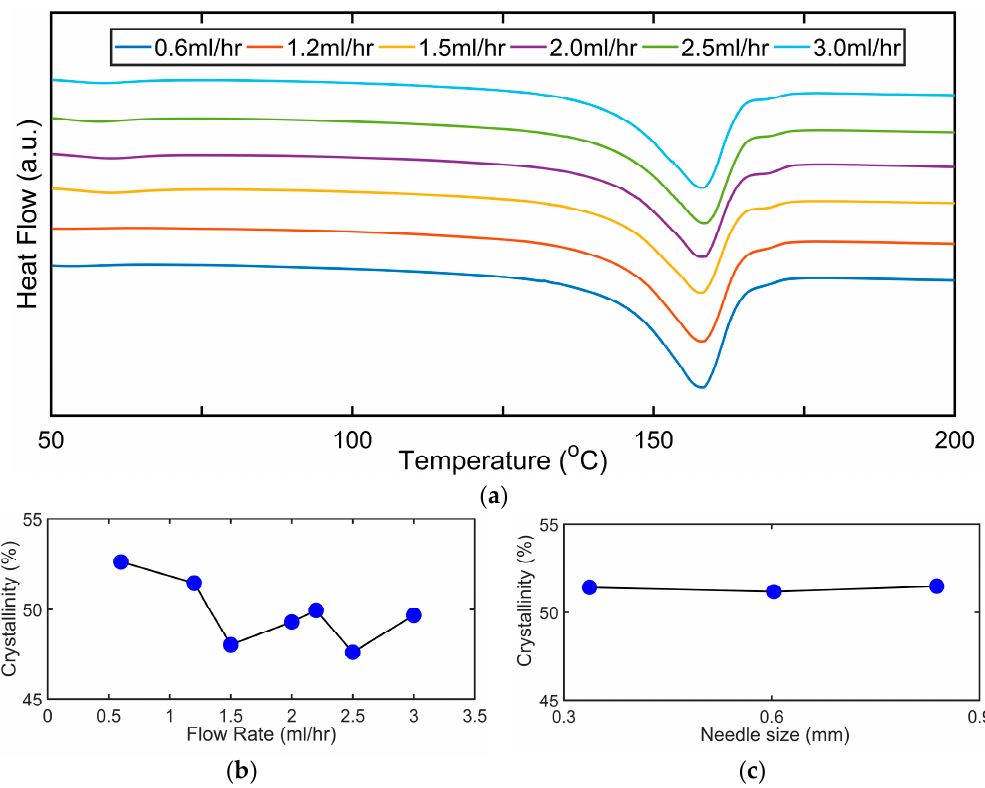
Figure 4. DSC characterization of various samples made with different flow rates and needle sizes: ( a ) the DSC thermograms for nanofibers obtained from different flow rate for the electrospinning process, the melting point was approximately around 158 °C for the nanofiber samples; ( b ) the variation of the crystallinity for different flow rates; ( c ) the variation of the crystallinity for different needle sizes employed for electrospinning.